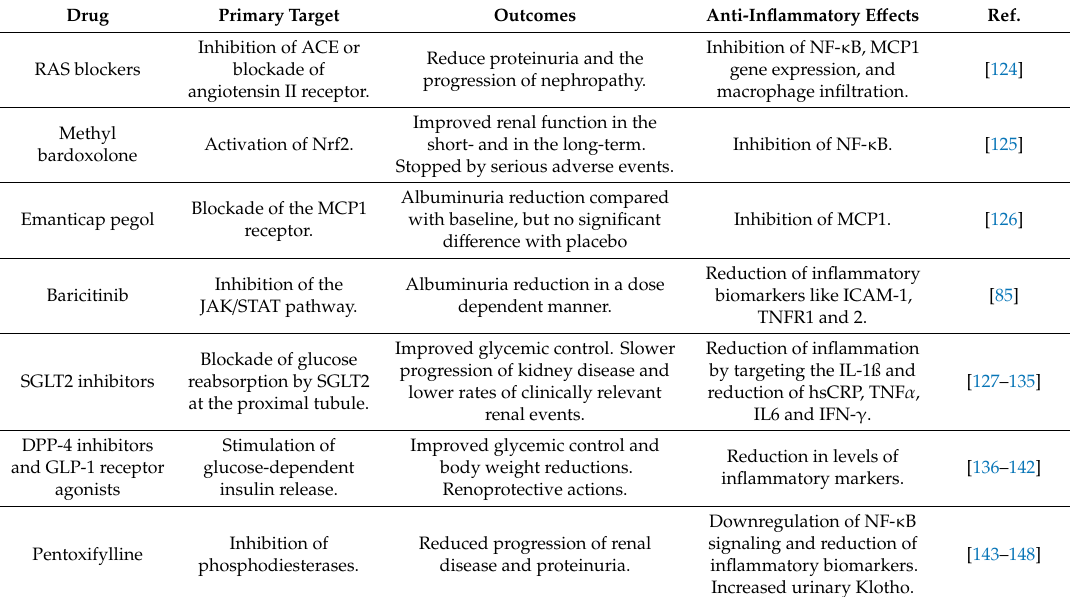
Table 1. Main therapies for diabetic kidney disease with anti-inflammatory